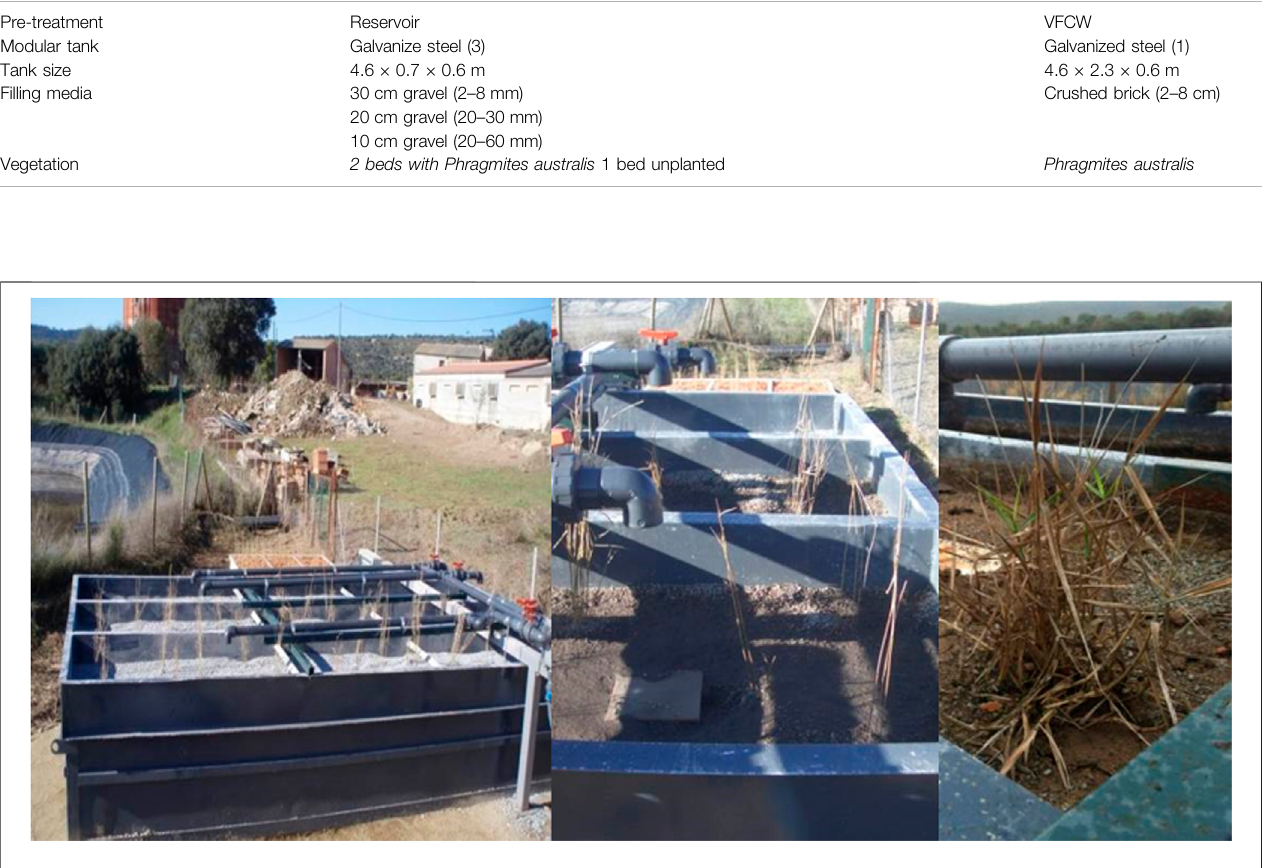
FIGURE 2 | VFCW pilot: general view, distribution pipe and Phragmites australis detail.